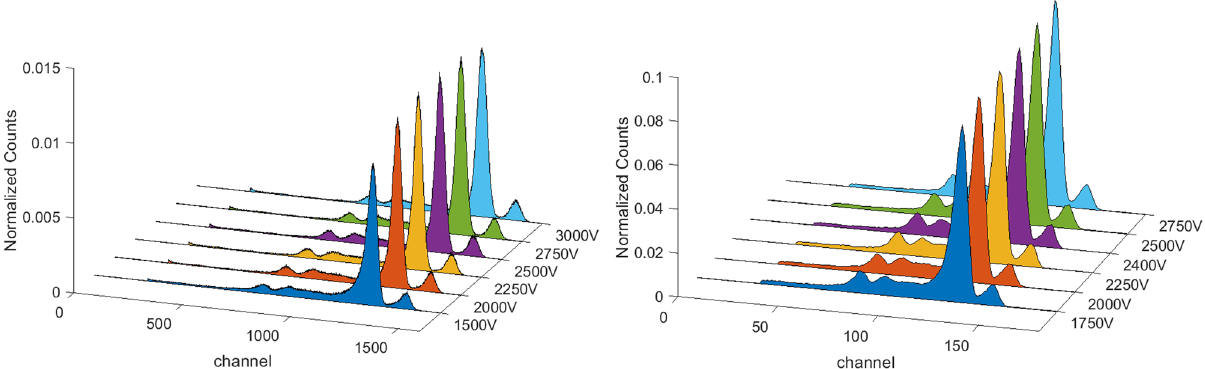
Figure 12. Co-57 spectra acquired from detector V22 2000B (right) and from detector V40 1250A (left) with different bias voltages. Measurements were carried out at 20 °C.